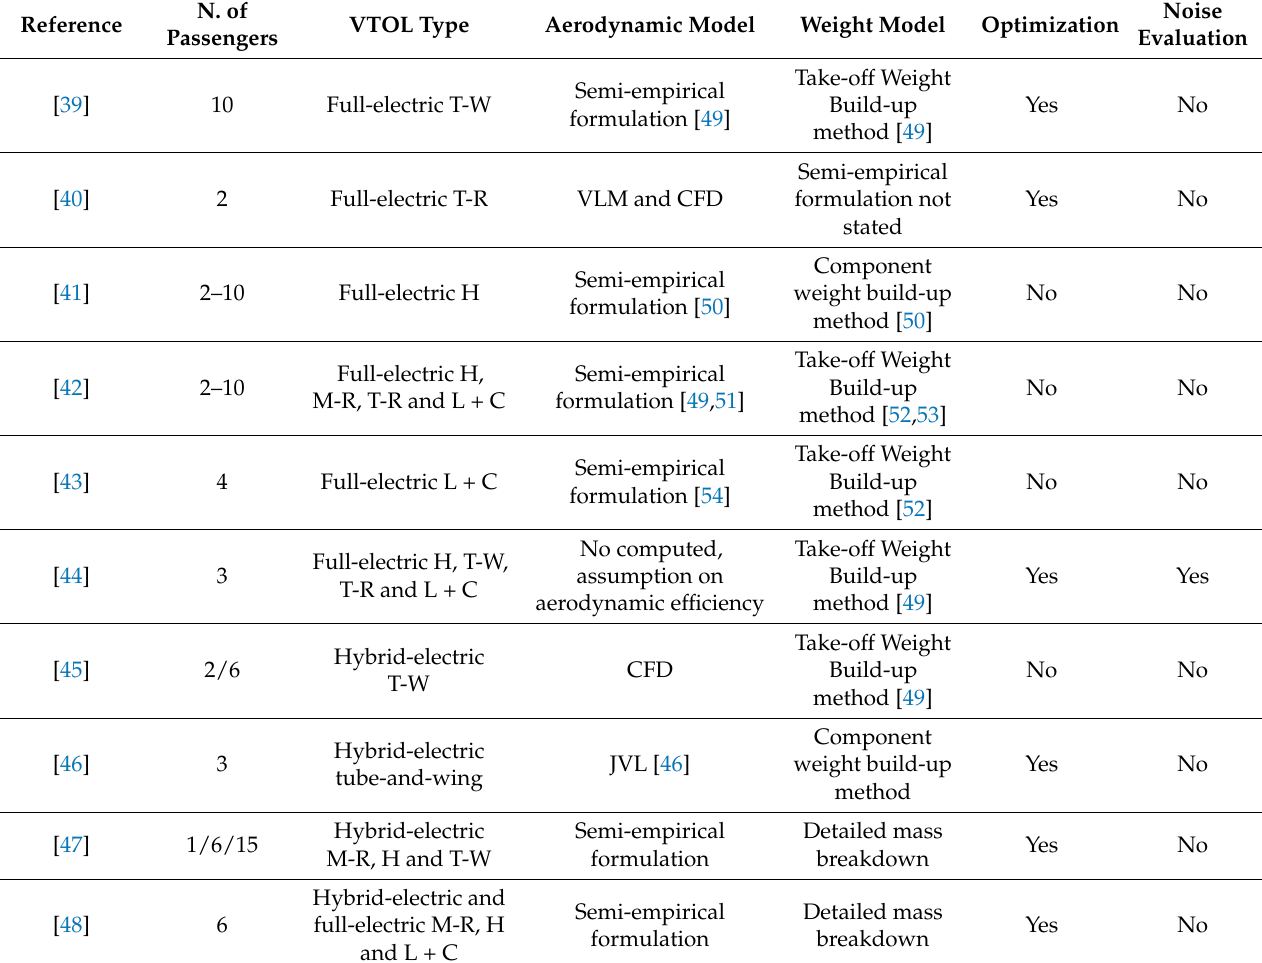
Table 2. Main information of the conceptual design methodologies described in